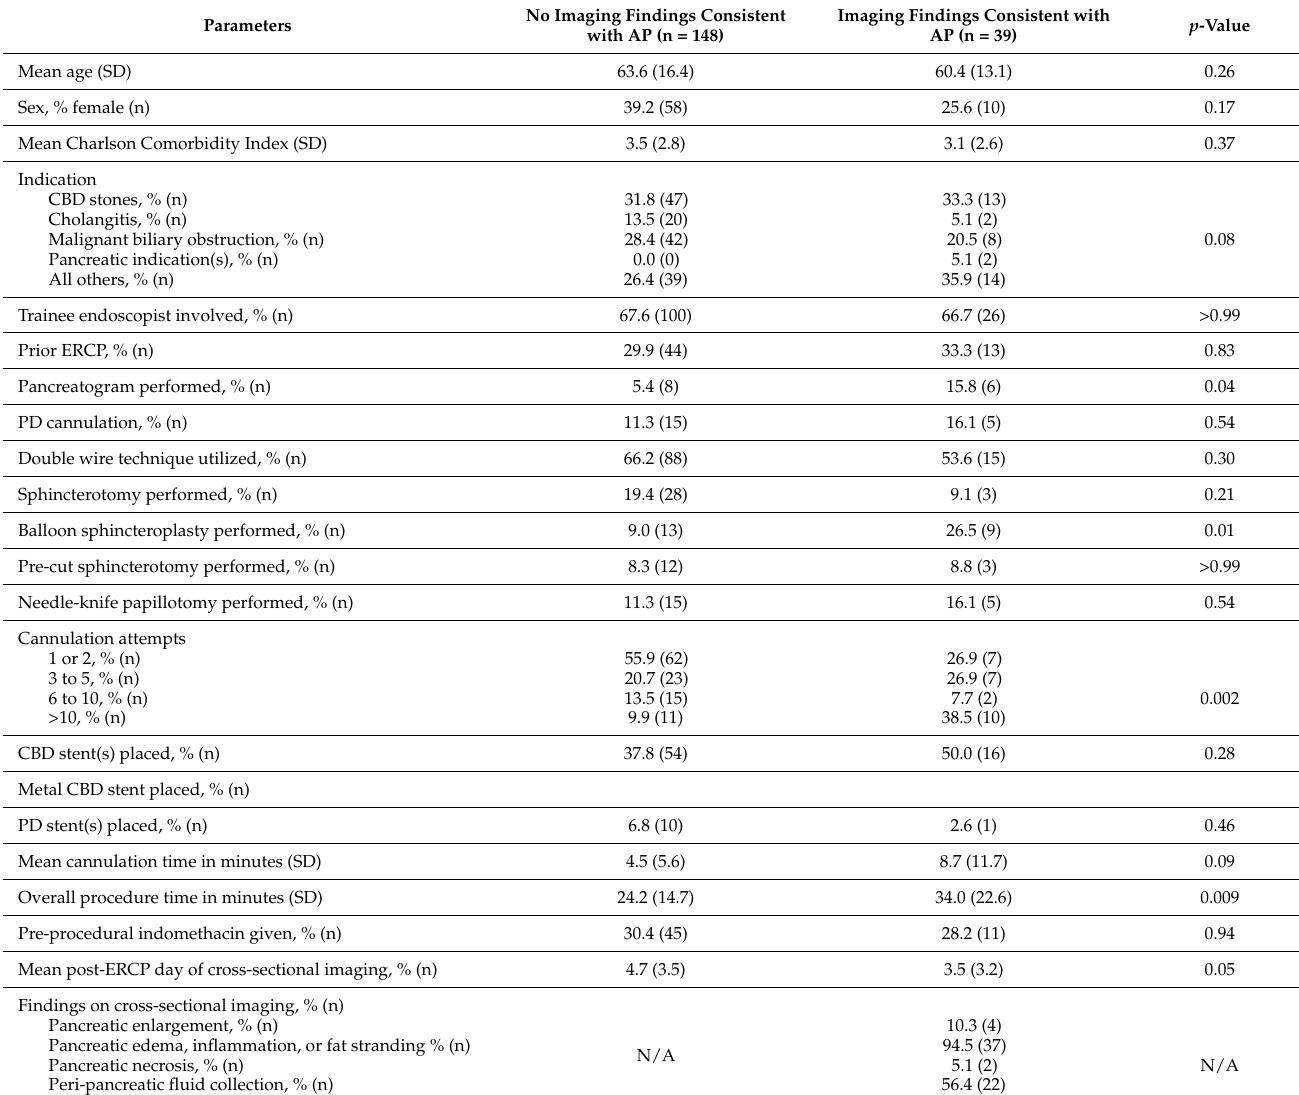
Table 2. Demographic, clinical and procedural details for patients with and without cross-sectional imaging findings consistent with acute pancreatitis following